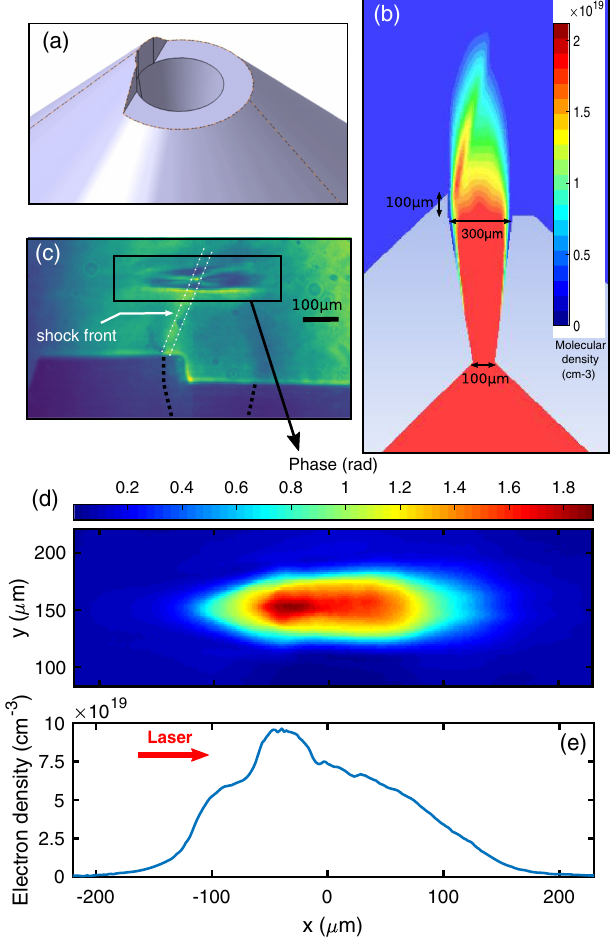
FIG. 1. (a) 3D model of the one-sided shock nozzle. (b) Molecu- lar density map from a 3D CFD simulation of an OSS jet performed with Fluent. Gas is N 2 and backing pressure P ¼ 20 Bar. Color map is capped at 2 . 1 × 10 19 cm − 3 for viewing purpose. (c) Shadow graphic side view image of the plasma. Black dotted line suggests the inner walls of the nozzle, white dotted lines follow the shock front. (d) Experimental phase from the plasma column measured with the wave-front sensor. The y -axis represents the distance from the nozzle exit, the x -axis is the laser propagation axis. (e) Electronic density profile at 150 μ m from the OSS nozzle ’ s exit, retrieved by Abel inversion of the phase map. Laser propagation direction is from left to right (red